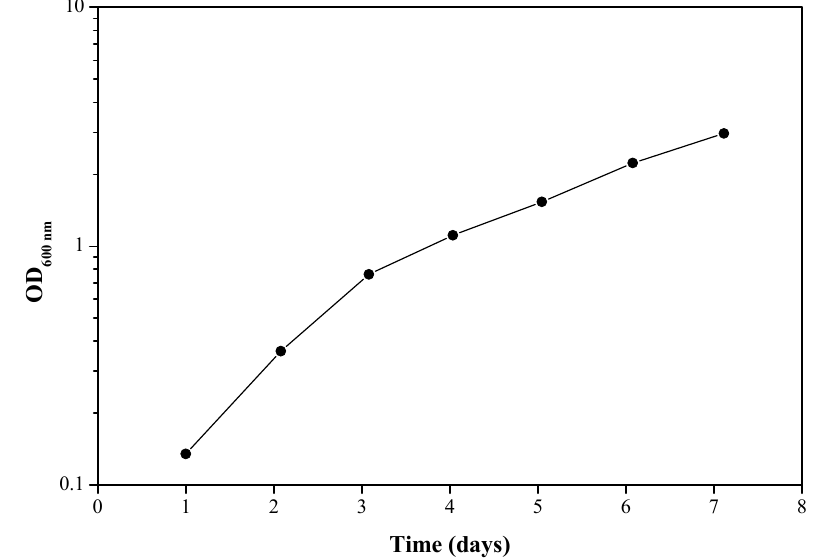
Figure 2. Bacterial growth over time in a culture sample after the 3rd enrichment. Carbon source: LY 5052 epoxy resin. Each experiment was repeated at least five times; a typical result is shown here.